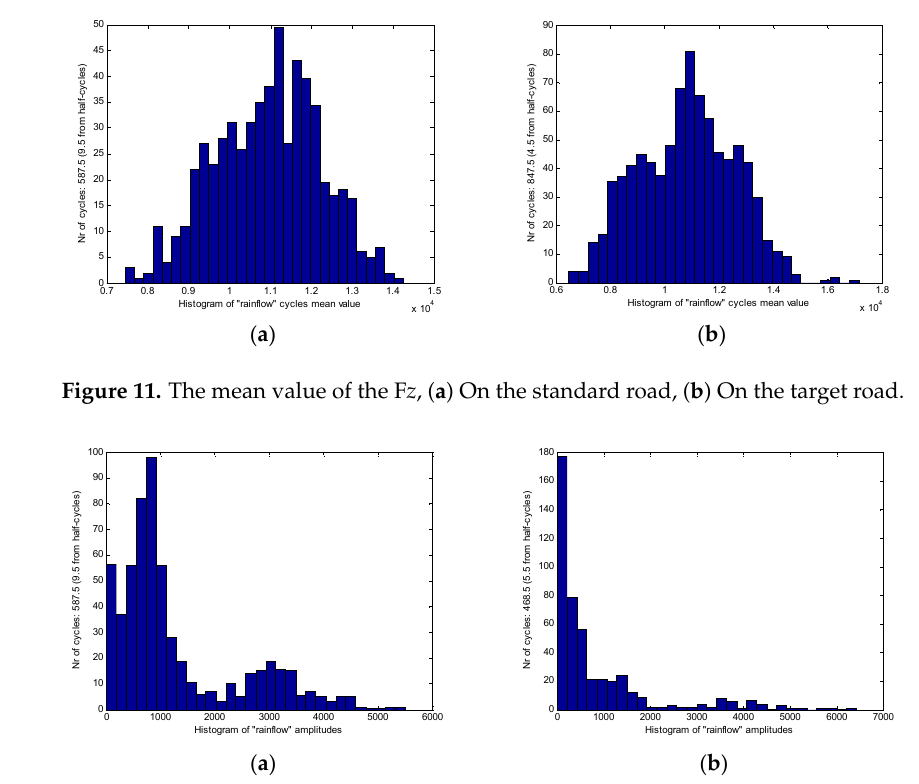
Sensors 2018 , 18 , x